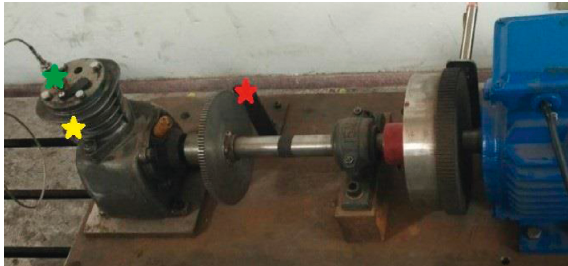
Figure 1: Arrangement of the